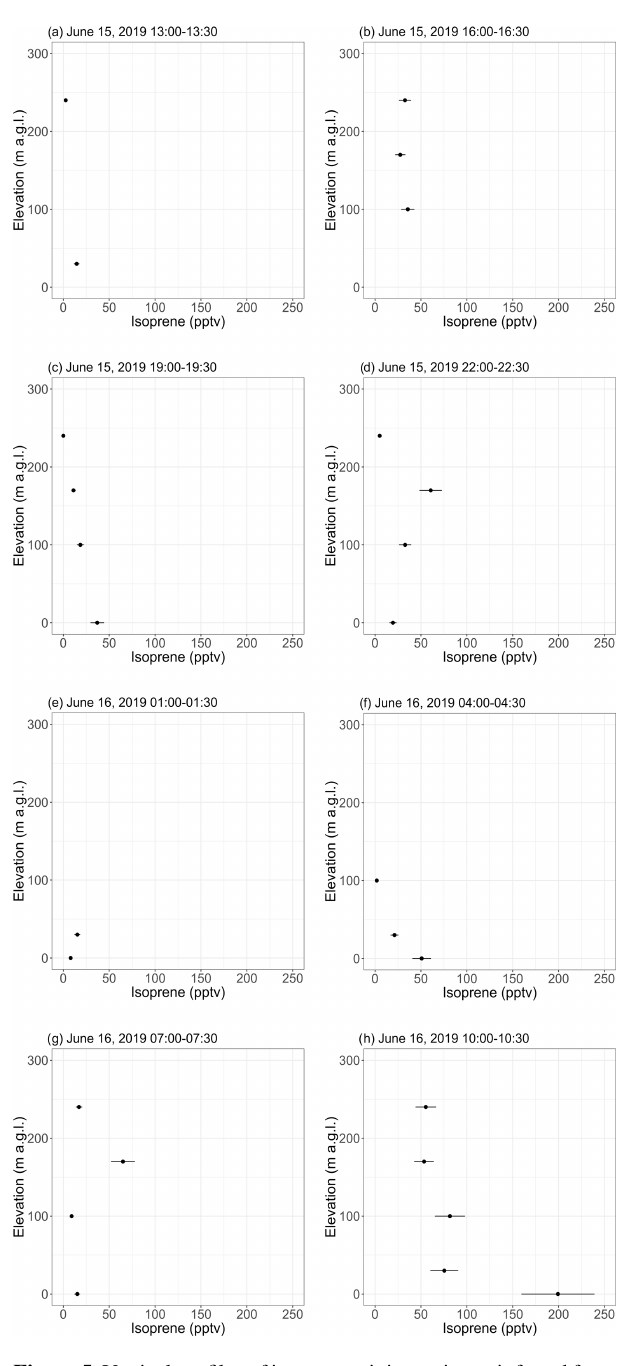
Figure 5. Vertical profiles of isoprene mixing ratios as inferred from 30min samples collected with a tethered balloon. The error bars show the analytical uncertainty for isoprene (20%). Samples with an isoprene mixing ratio lower than blanks were discarded. Times are given as Alaska standard time (UTC −